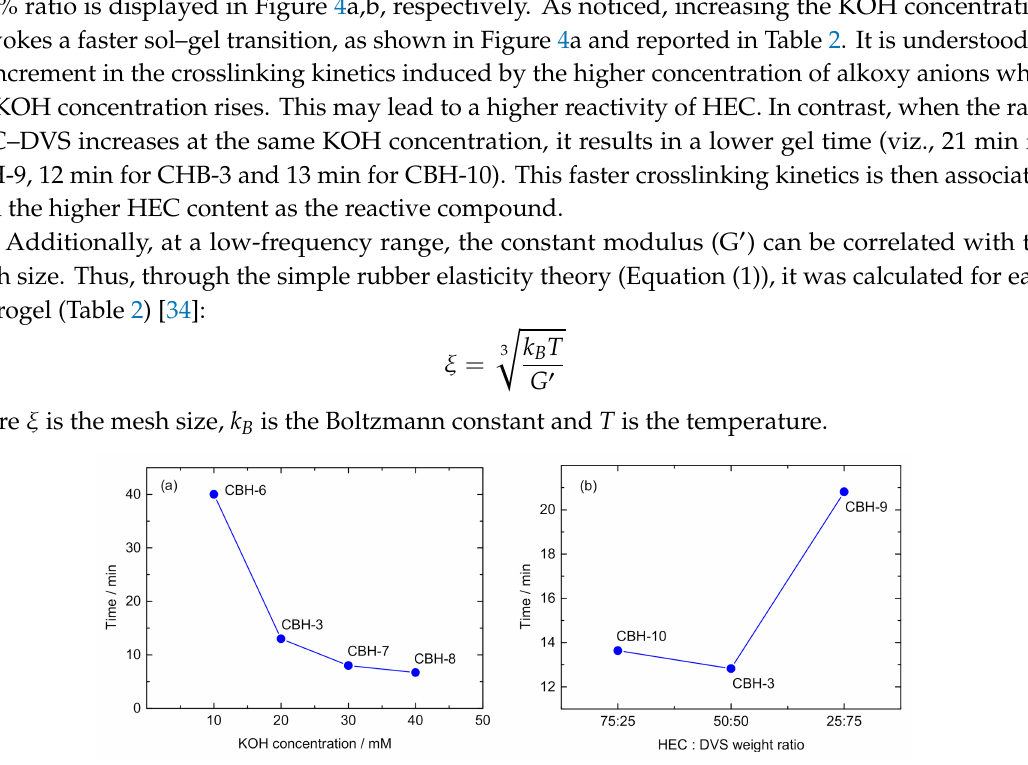
Figure 4. Sol–gel transition of hydrogels depending on ( a ) concentration of KOH and ( b ) HEC–DVS weight